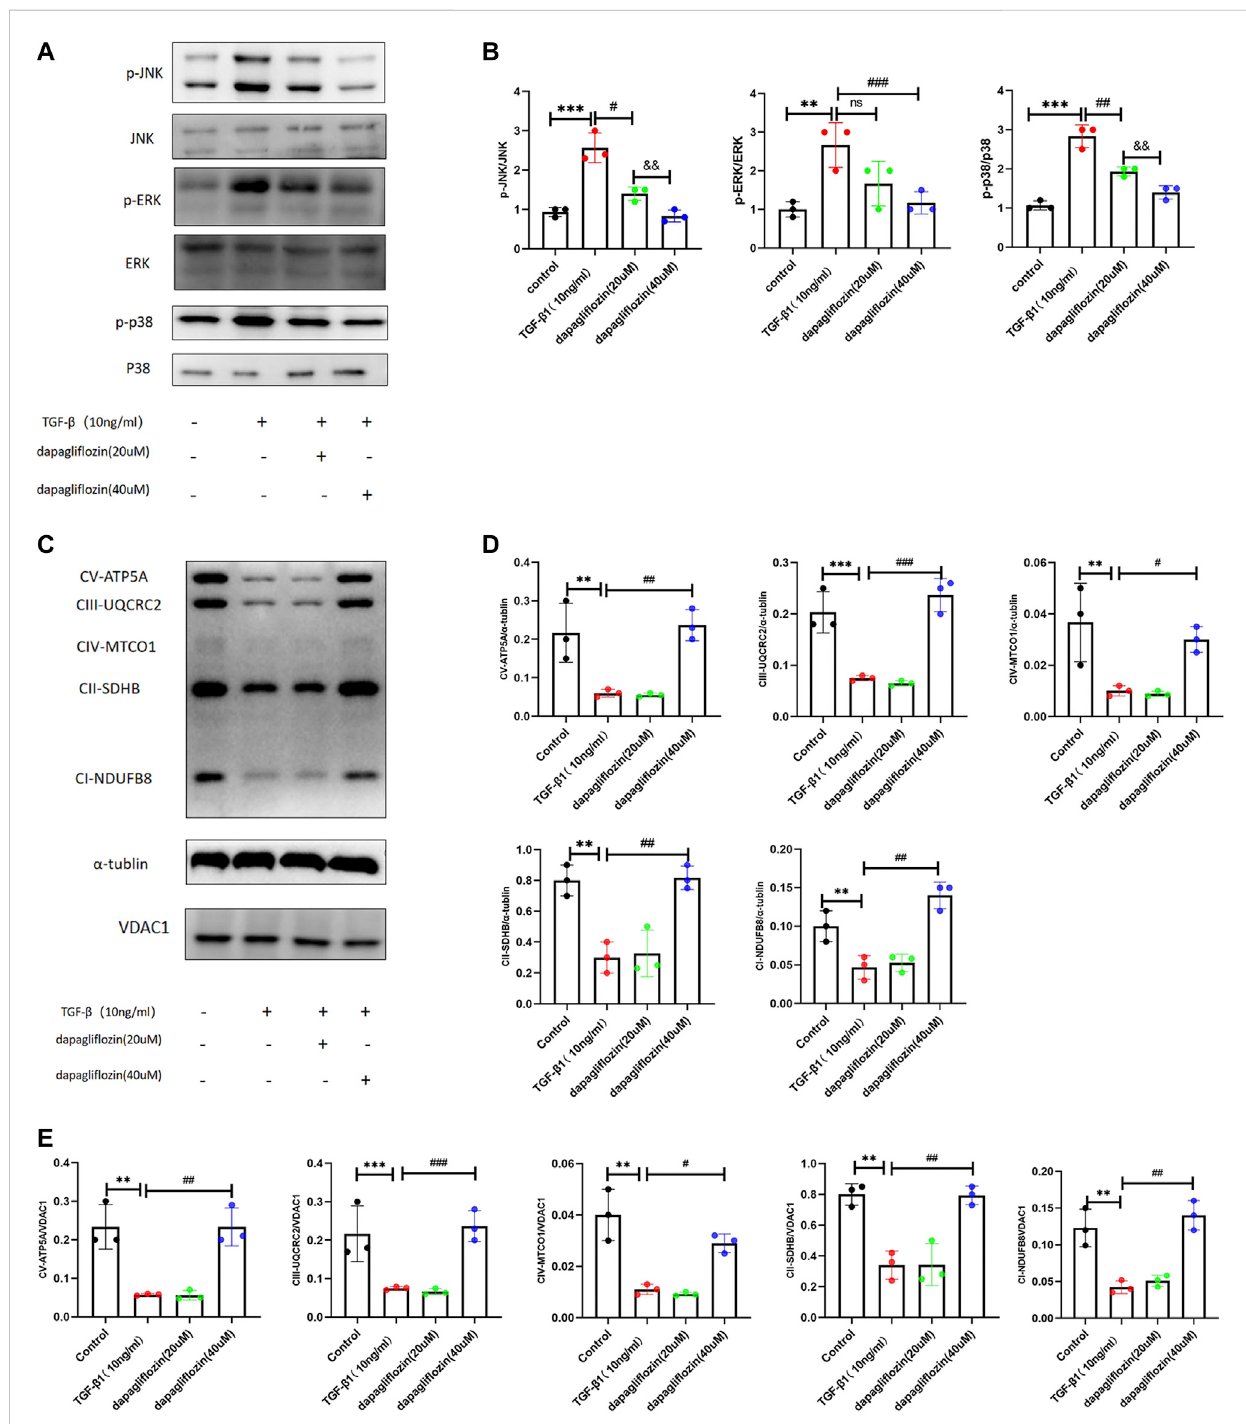
FIGURE 8 Dapagli fl ozin inhibited activation of the TGF- β 1/MAPK pathway and attenuated the reductions of mitochondrial respiratory chain complexes in HK2 cells stimulated by TGF- β 1. (A, B) Western blot showing the expression of p-JNK, p-ERK, and p-P38 in HK2 cells in each group. (C – E) Western blot showing the expression of mitochondrial respiratory chain complexes (oxphos) in HK2 cells in each group. Values are means ± SD. ** p < 0.01 TGF- β 1 stimulated group compared with the control group; *** p < 0.001 TGF- β 1 stimulated group compared with the control group; # p < 0.05 dapagli fl ozin treatment group compared with the TGF- β 1 stimulated group; ## p < 0.01 dapagli fl ozin treatment group with the TGF- β 1 stimulated group compared; ### p < 0.001 dapagli fl ozin treatment group compared with the TGF- β 1 stimulated group; and p < 0.01 20 μ M dapagli fl ozin treatment group compared with the 40 μ M dapagli fl ozin treatment